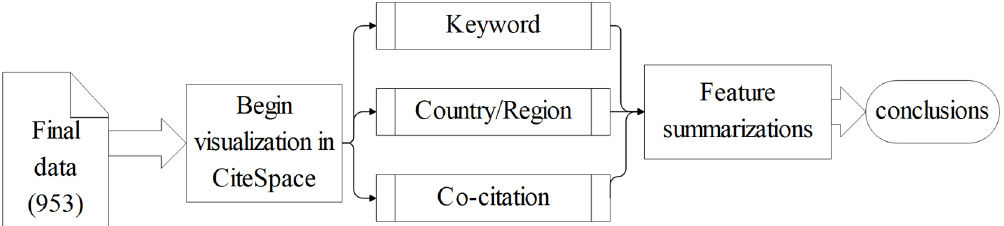
Figure 6. Flowchart of bibliometric program analysis.